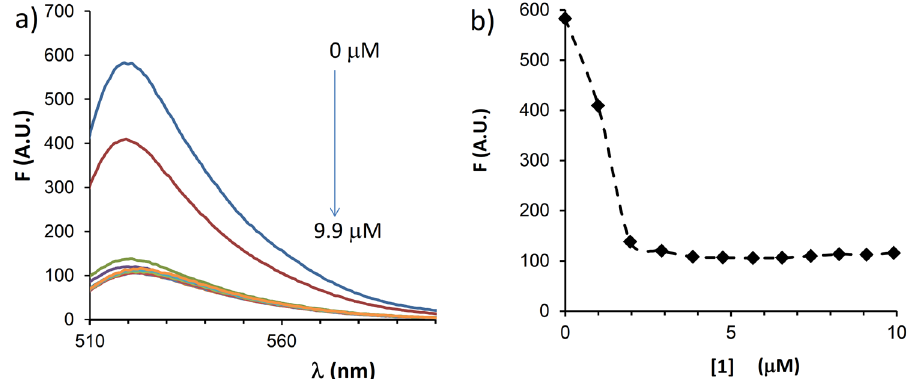
Figure 4. Interaction of PNA with calixarene 1 . Changes in fluorescence intensity of fluorescein labelled Fl-a221PNA (2 µ M) upon addition of increasing concentration (0, 1.0, 2.0, 2.9, 3.9, 4.8, 5.7, 6.5, 7.4, 8.3, 9.1, 9.9 μ M) of calixarene 1 in buffer solution (HEPES 16 mM, NaCl 40 mM, pH 7.4); ( A ) emission spectra of Fl-a221PNA ( λ ex = 494 nm); ( B ) Fluorescence intensity at maximum vs calixarene